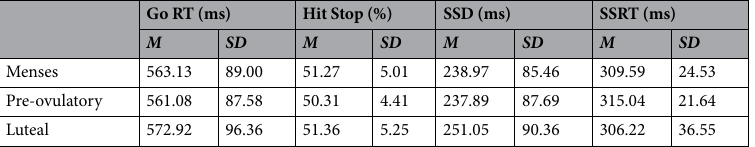
Table 2. Behavioral indices across the different cycle phases of the menstrual cycle. N = 36. RT: reaction time;